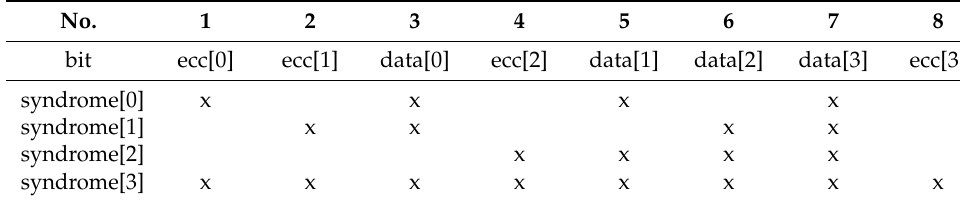
Table 2. Syndrome calculation logic.